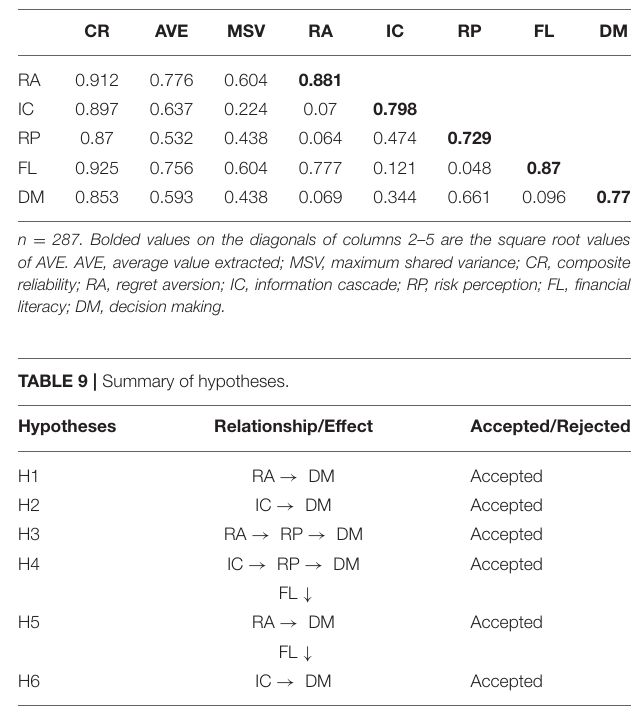
TABLE 10 | Index of mediation